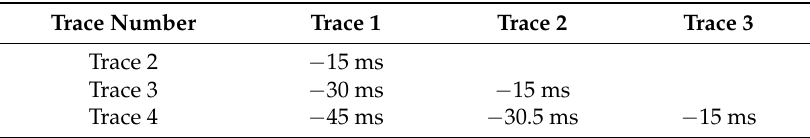
Table 2. The arrival time differences of all the pairs of traces.